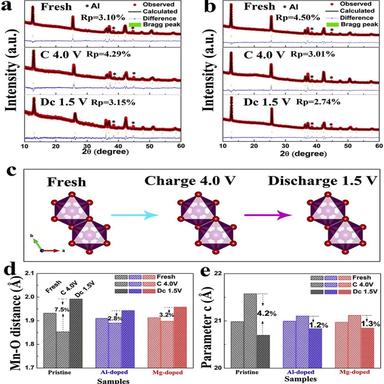
Rietveld refinement of XRD patterns collected at fresh electrode, charged 4.0 V, and discharge 1.5 V during first cycle for (a) pristine and (b) Al-doped sample. (c) The structural evolution of MnO6 octahedra along the z-axis during first cycle. The comparation of (d) Mn–O distance and (e) crystal parameter c for pristine, Aldoped and Mg-doped samples obtained from the Rietveld refinement.